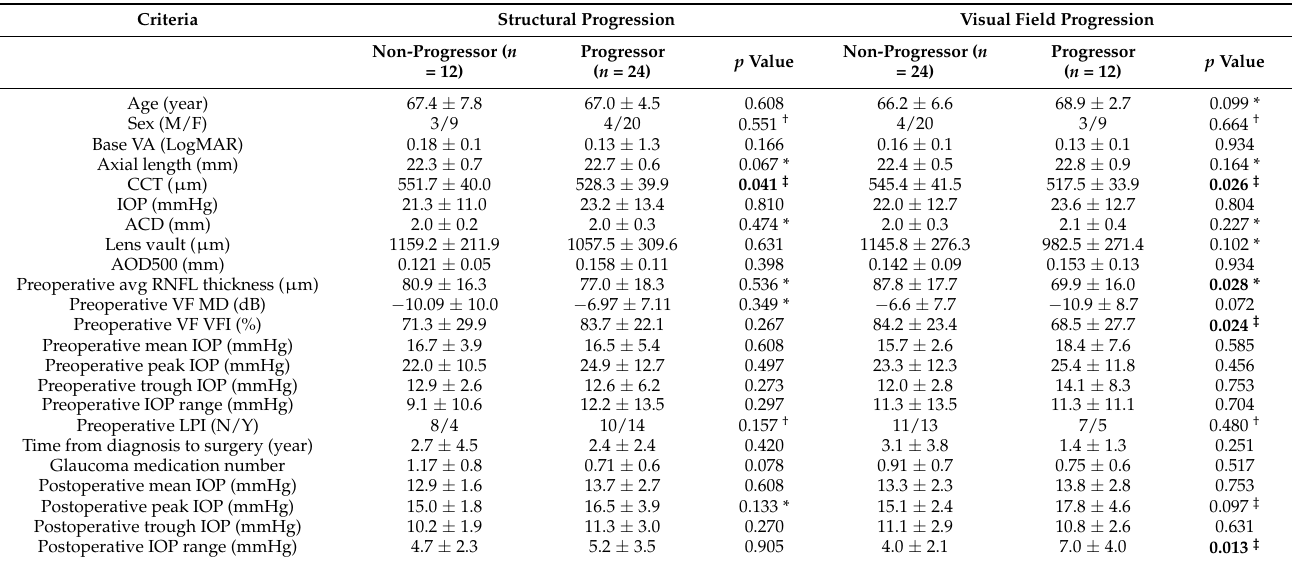
M = male; F = female; VA = visual acuity; logMAR = logarithm of the minimal angle of resolution; CCT = central corneal thickness; IOP = intraocular pressure; ACD = anterior chamber depth; AOD = angle opening distance; RNFL = retinal nerve fiber layer; VF = visual field; MD = mean deviation; VFI = visual field index; LPI = laser peripheral iridotomy; N = none; Y = yes; * = chi-squared test; = † p < 0.05 by Mann–Whitney test unless otherwise indicated. Table 3. Comparison of demographics and clinical characteristics of progressed and non-progressed eyes with primary angle closure